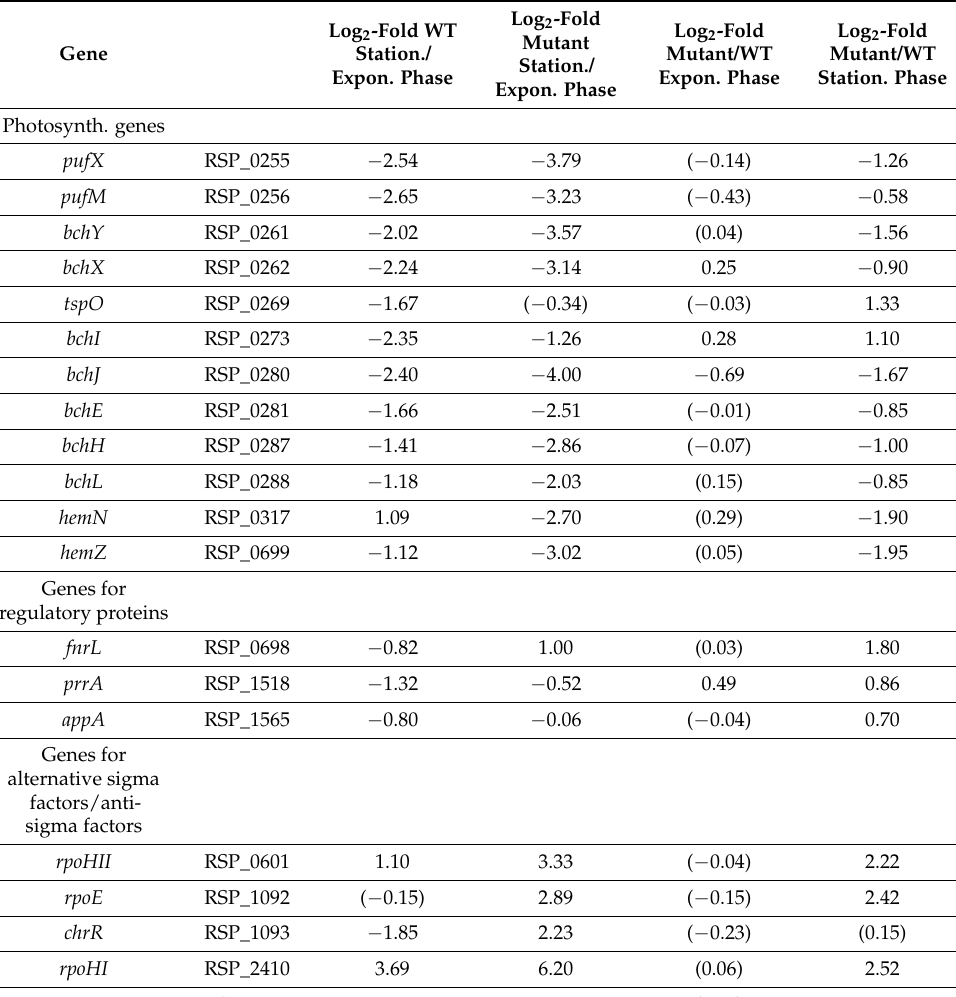
Table 1. log 2 -fold changes in read counts determined by RNAseq within a strain between different growth phases or between wild type (WT) and the stsR mutant in the same growth phase, as calculated by DEseq2 [39]. Brackets indicate that the adjusted p -value is >0.05. Growth curves for the two strains are shown in Figure S2 and the time points of sampling are indicated. Log 2 -Fold Log 2 -Fold WT Log 2 -Fold Log 2 -Fold Mutant Gene Station./ Mutant/WT Mutant/WT Station./ Expon. Phase Expon. Phase Station. Expon. Phase